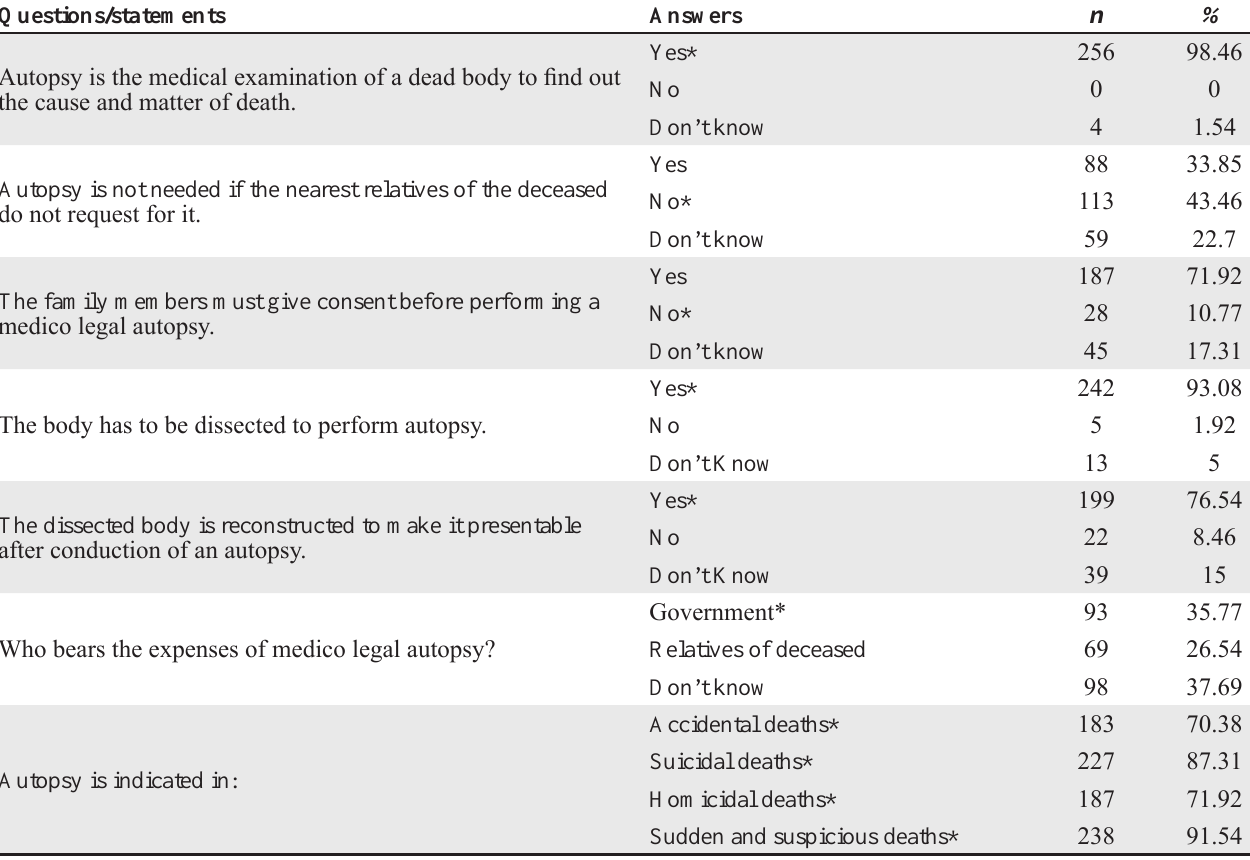
Table 2 : Knowledge of medico legal autopsy among the participants (N = 260) Questions/statements